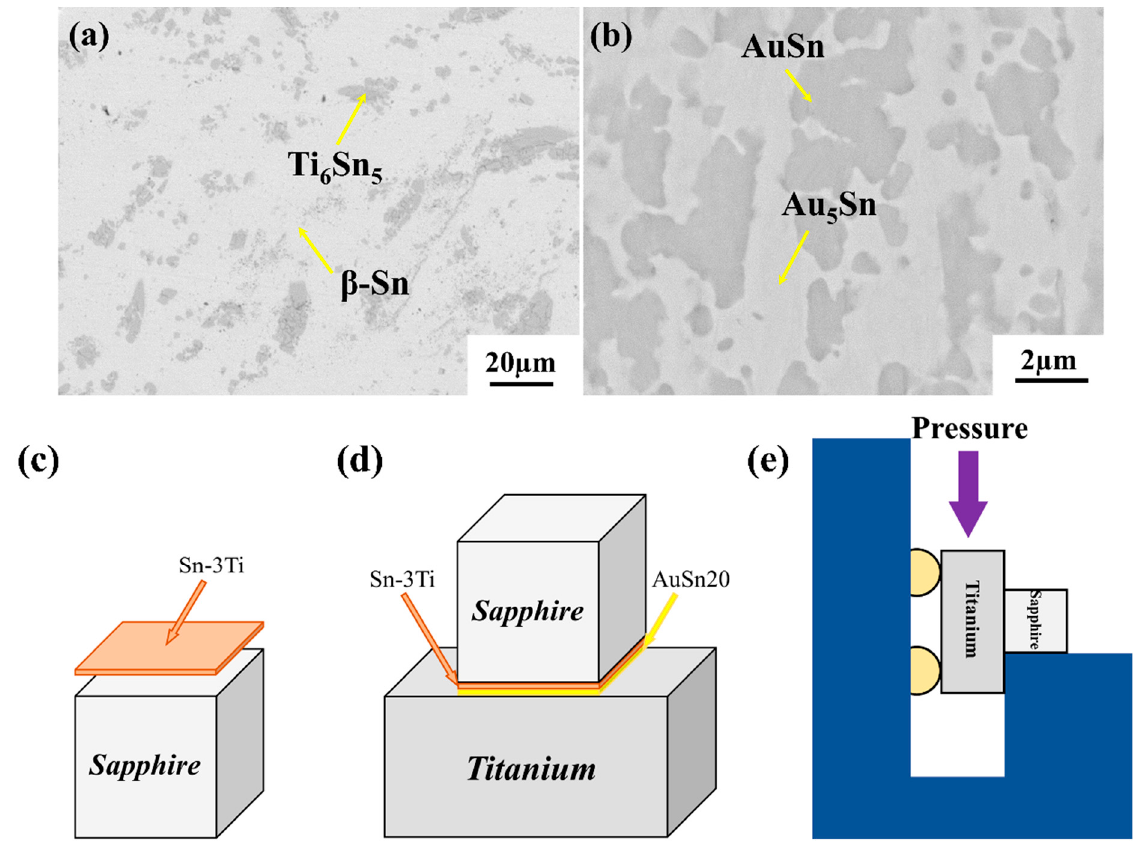
Figure 1. Microstructure of ( a ) Sn-3Ti and ( b ) AuSn20 and schematic diagram of ( c ) surface metallization test, ( d ) brazing assembly, and ( e ) shear test.